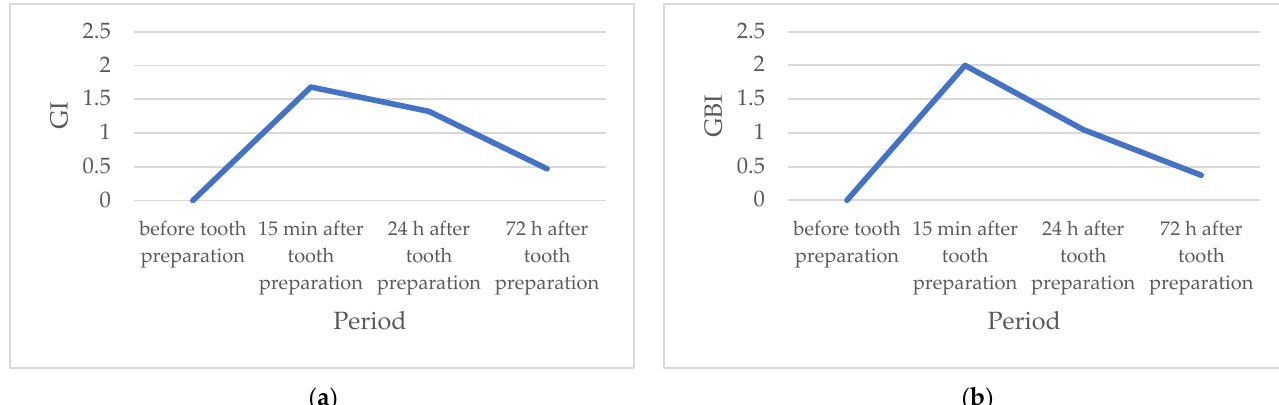
Figure 1. ( a ) Mean values of the gingival index (GI) during the study period; ( b ) Mean values of the gingival bleeding index (GBI) during the study period.